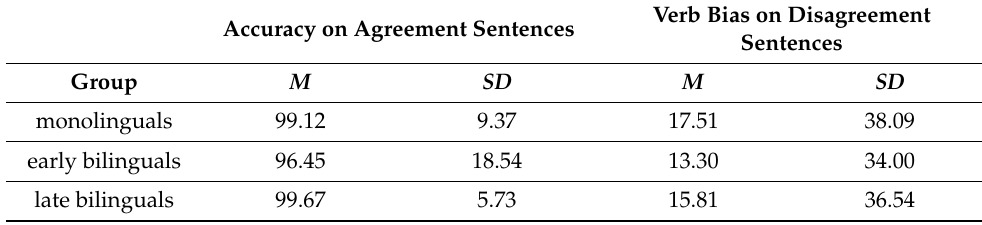
Table 3. Descriptive statistics in % for accuracy on picture